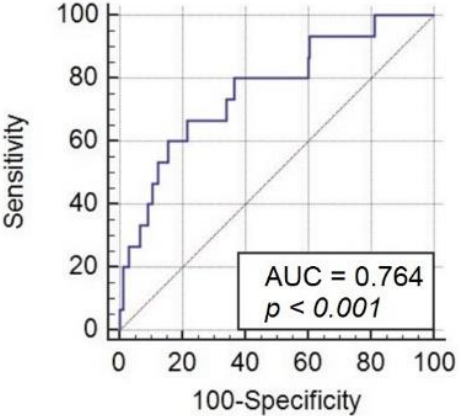
Figure 1. Area under the receiver operating characteristic (AUC) ROC curve of NT-proBNP for cardiogenic shock requiring extracorporeal membrane oxygenation following valve surgery. Table 1. Baseline characteristics of the study population.